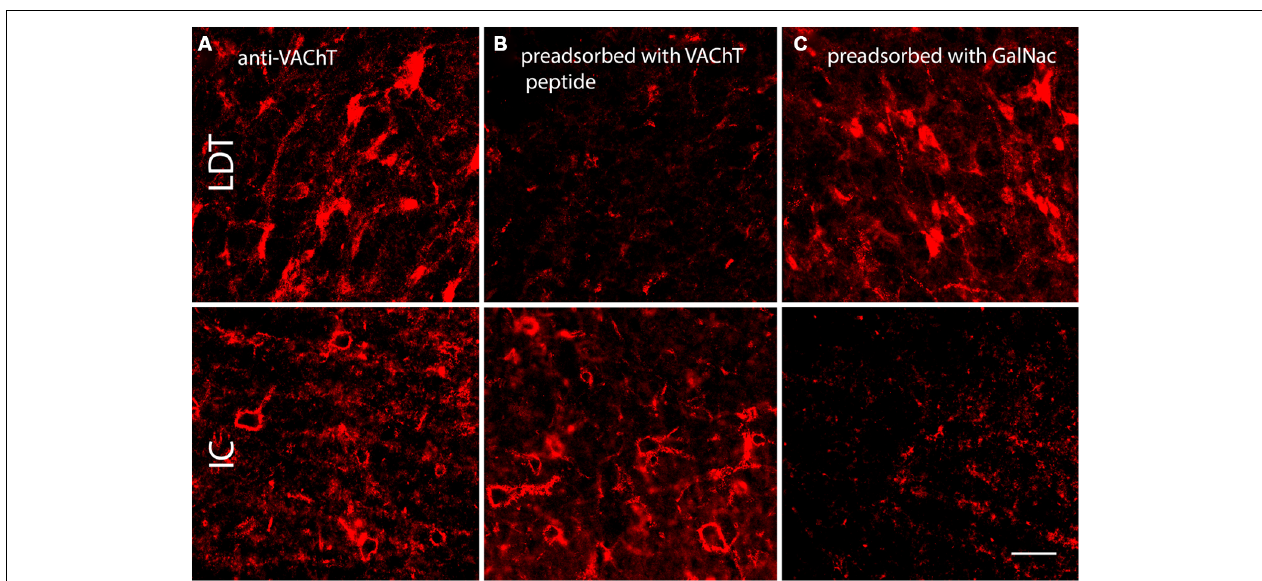
FIGURE 6 | Photomicrographs showing anti-VAChT staining in the laterodorsal tegmental nucleus (LDT, a midbrain cholinergic nucleus) and the IC under different pre-adsorption conditions. (A) . Somatic staining in the LDT (top row) and PN-like staining in the IC (bottom row) following application of anti-VAChT antibody to guinea pig tissue. (B) . Following pre-adsorption of the anti-VAChT antibody with VAChT